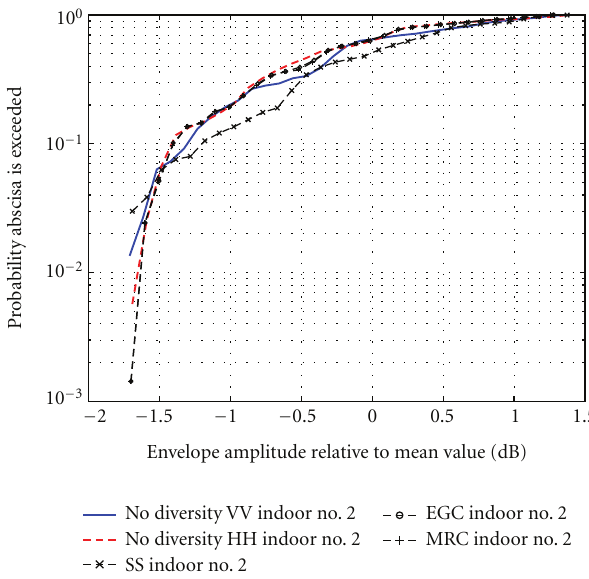
Figure 6: CDFs for di ff erent combination methods in indoor number 2 scenario at 41.4